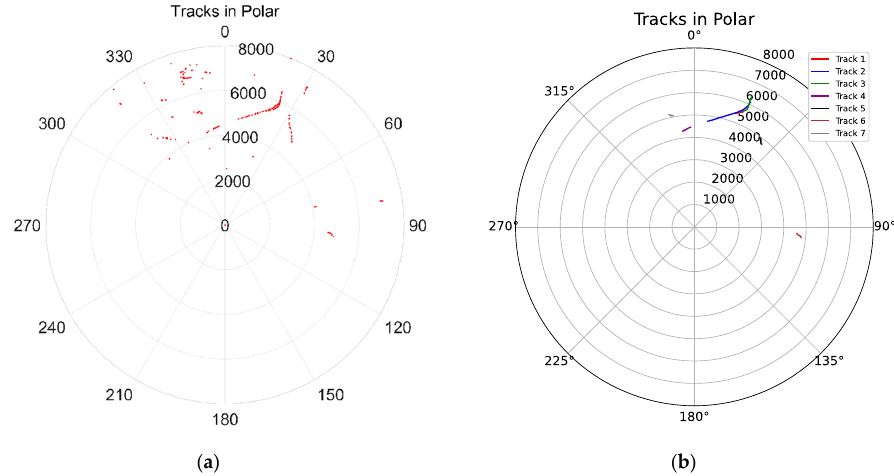
Figure 19. Tracks in polar coordinates under multi-target tracking. ( a ) Tracks of point-target tracking. ( b ) Tracks of extended target tracking.